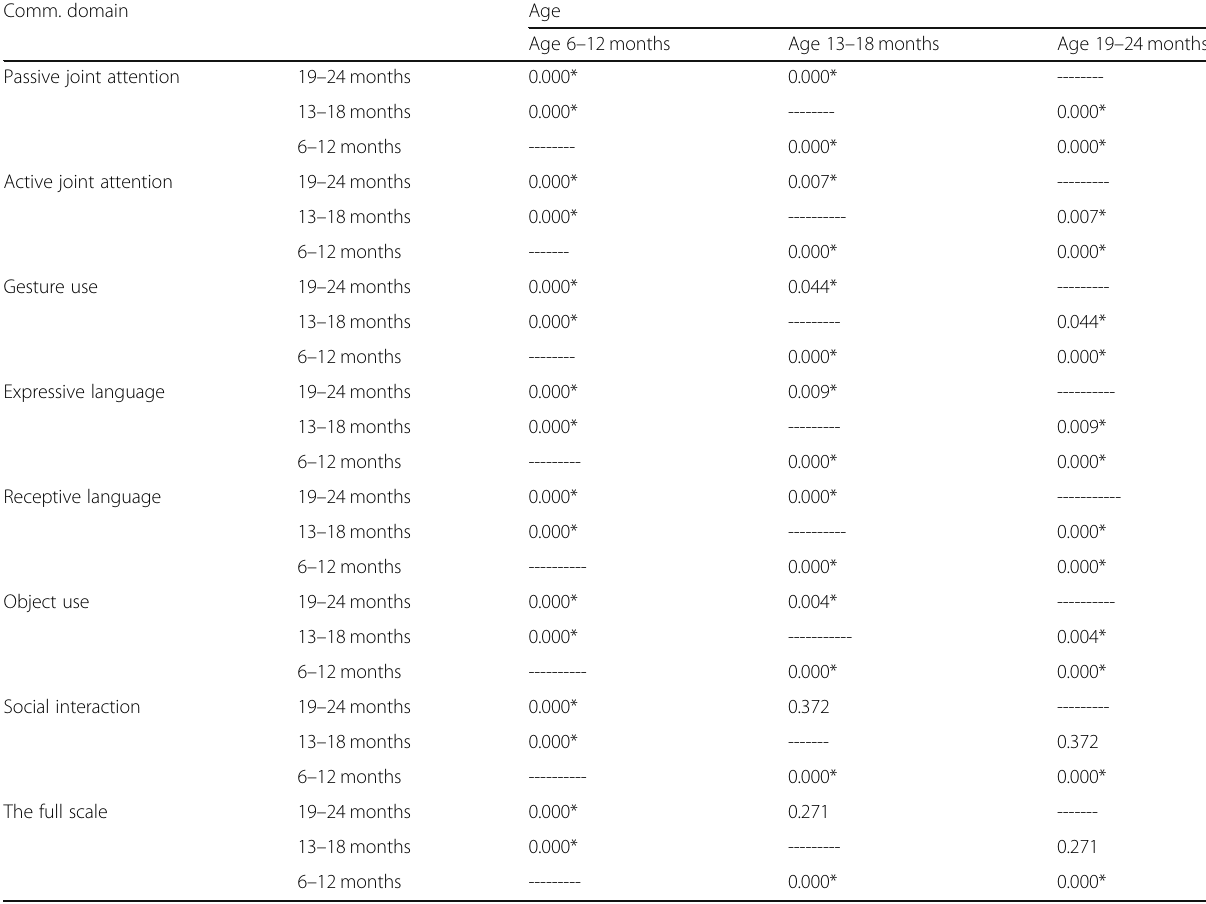
Table 8 The significance of difference between the mean score in each scale among the three groups Comm. domain